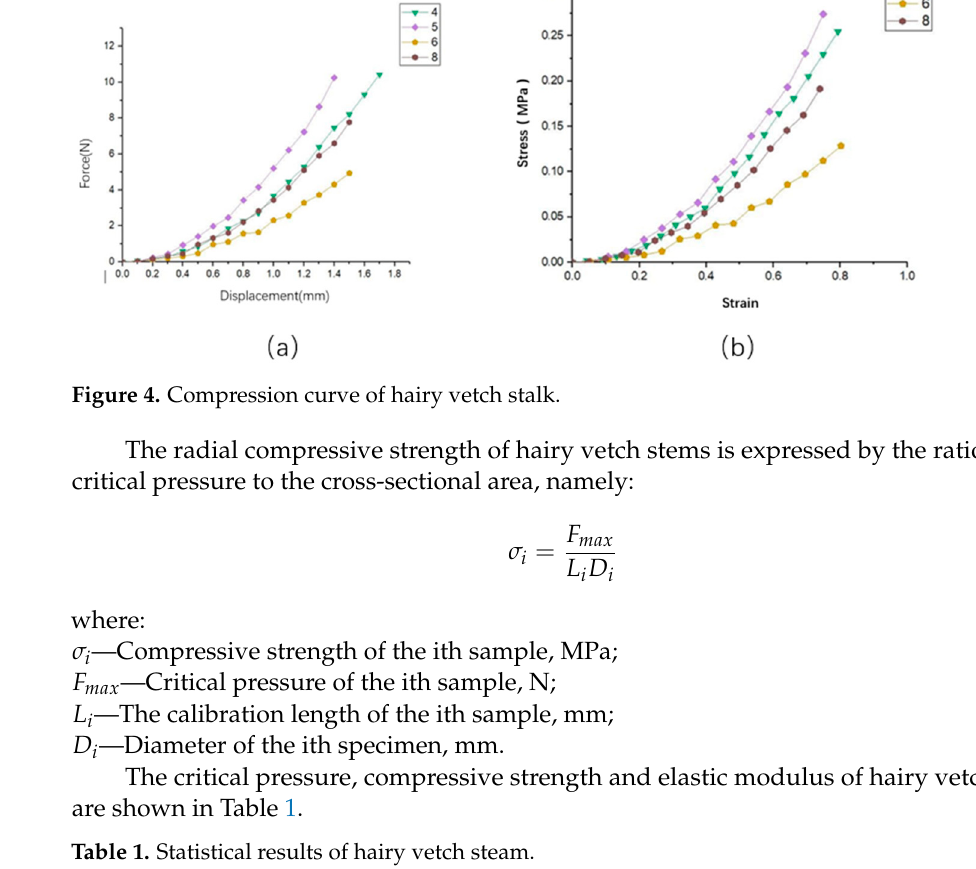
Table 1. Statistical results of hairy vetch